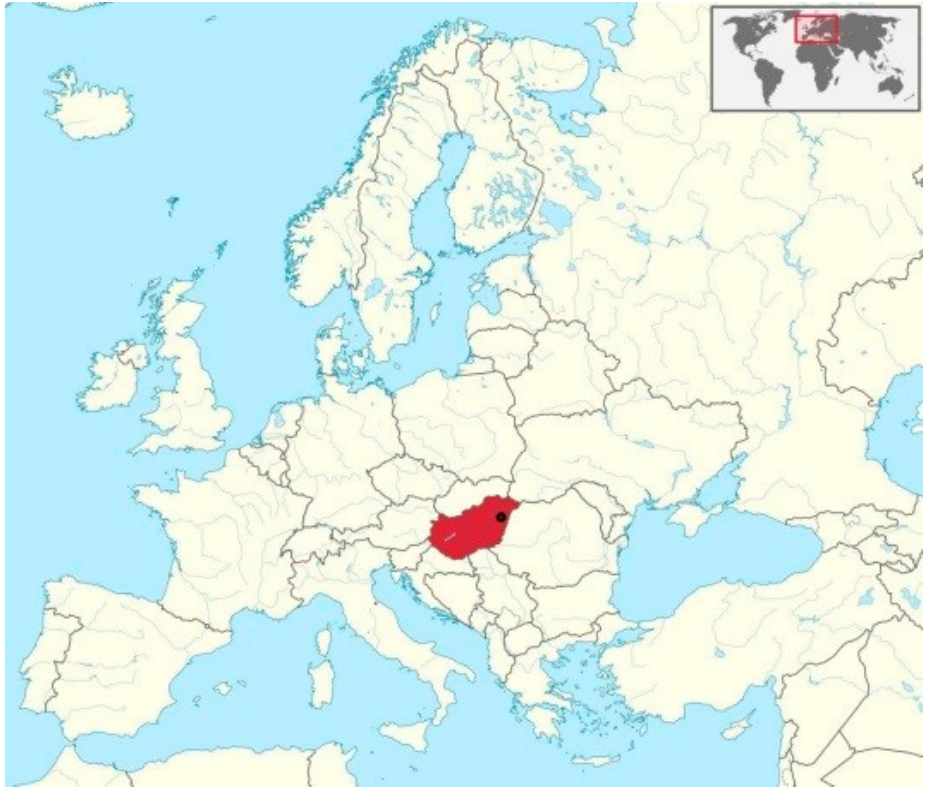
Figure 1. The study area in Hungary, representing warm temperate dry climate zone.